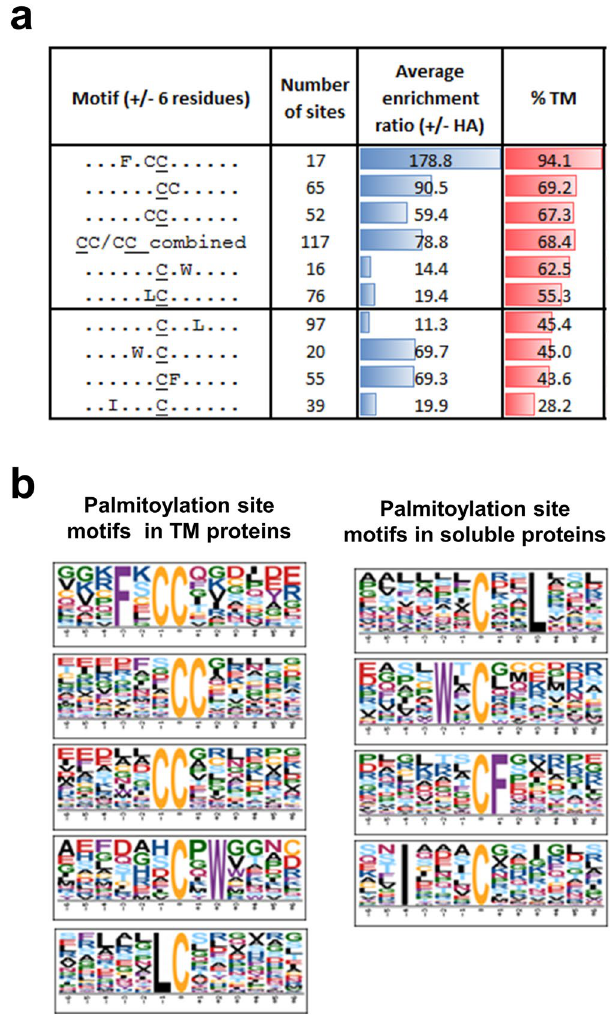
Figure 5. Palmitoylation site motifs distinguish palmitoylation of transmembrane and soluble proteins. ( a , b ) Motif-x was used to identify significantly enriched sequence motifs in sequences + / − 6 residues in the set of 906 enriched palmitoylation sites compared to the mouse proteome. Re-analysis of palmitoylation sites from proteins with transmembrane helices and those that do not (soluble proteins) revealed that these two types of palmitoylated proteins have distinct enriched sequence motifs with transmembrane proteins containing mainly di-cysteine containing motifs and soluble proteins containing single cysteine residues and leucine, tryptophan, phenylalanine and isoleucine and specific